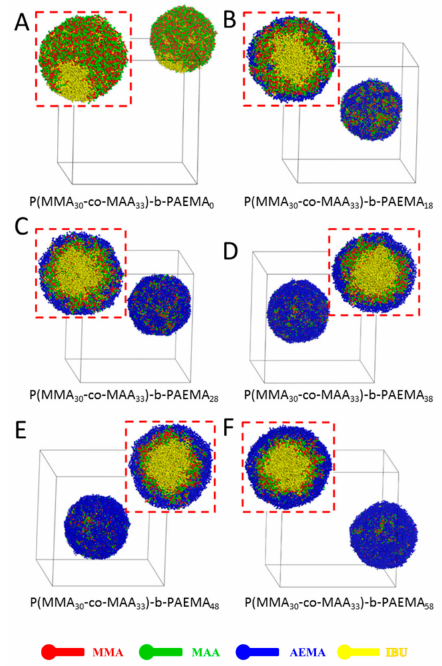
Figure 2. Full-section and cross-section views of IBU-loaded PMs at di ff erent ratios of PAEMA block at 400,000 steps during DPD simulation. (poly(MMA 30 - co -MAA 33 )- b -PAEMA z , ( A ) z = 0, ( B ) z = 18, ( C ) z = 28, ( D ) z = 38, ( E ) z = 48, ( F ) z =